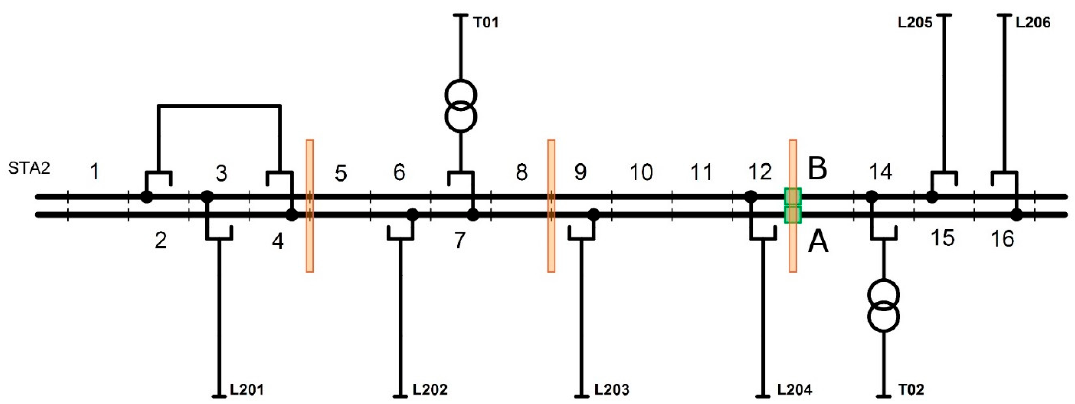
Figure 9. Layout of substation with bus bar system guy-wire sections (Adapted with permission from [14], Piechocki, P. Frackowiak, R., Eksploatacja i Niezawodno´s´c—Maintenance and Reliability, Polish Maintenance Society, 2017).